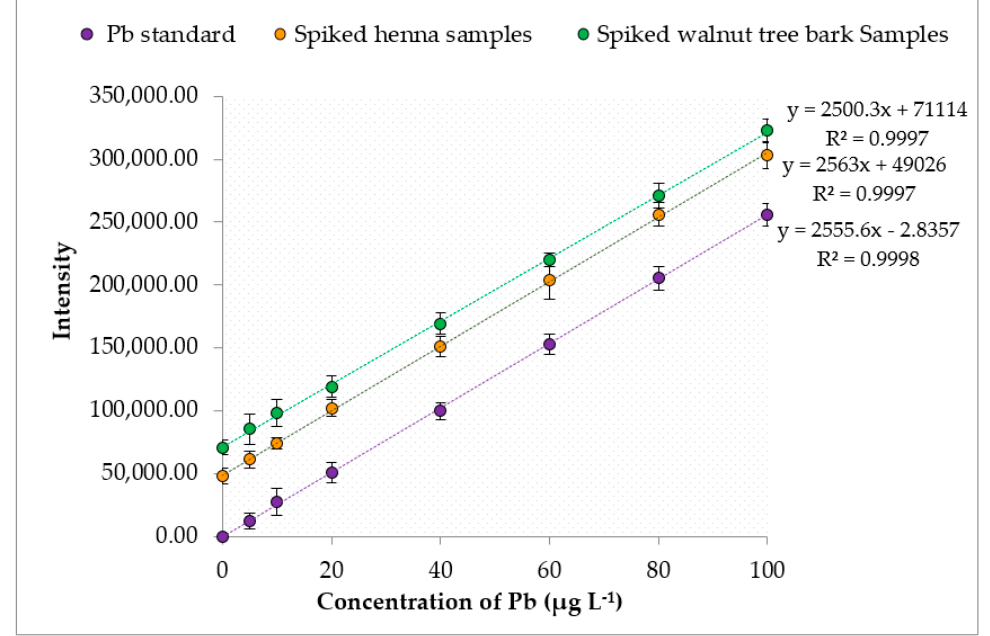
Figure 1. Recoveries of Pb from spiked henna and walnut tree bark samples.